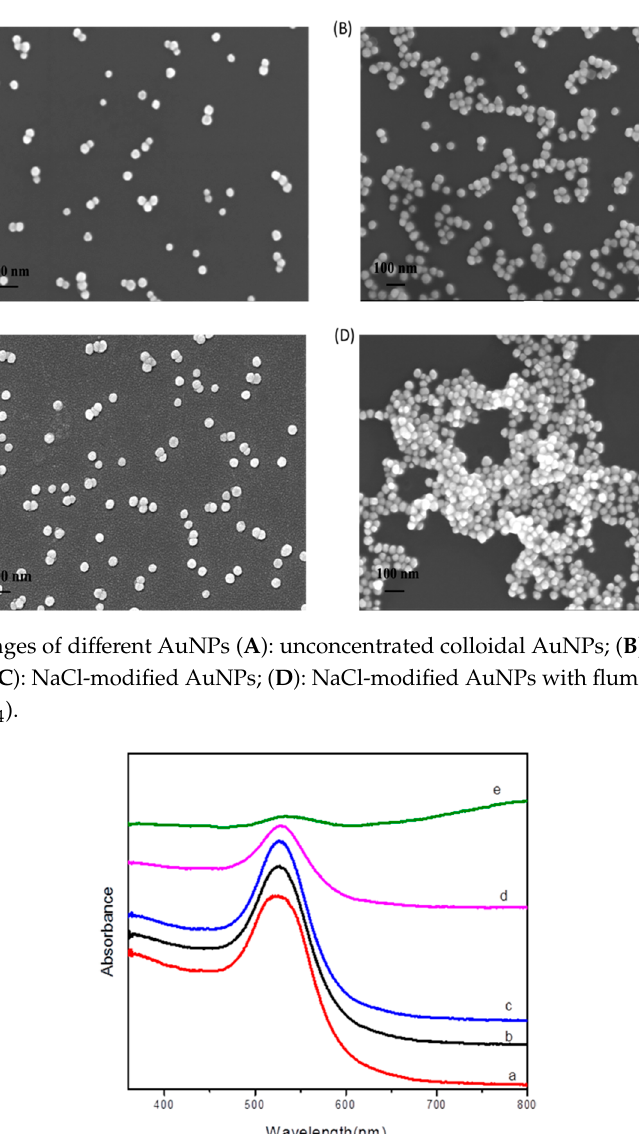
Figure 2. UV-vis absorption spectra of five di ff erent samples (a: AuNPs colloid, b: 2 × concentrated AuNPs colloid, c: NaCl-modified AuNPs colloid, d: NaCl-modified AuNPs colloid with flumetsulam (1000 µ g / L), and e: NaCl-modified AuNPs colloid with flumetsulam (1000 µ g / L) under the addition of MgSO 4